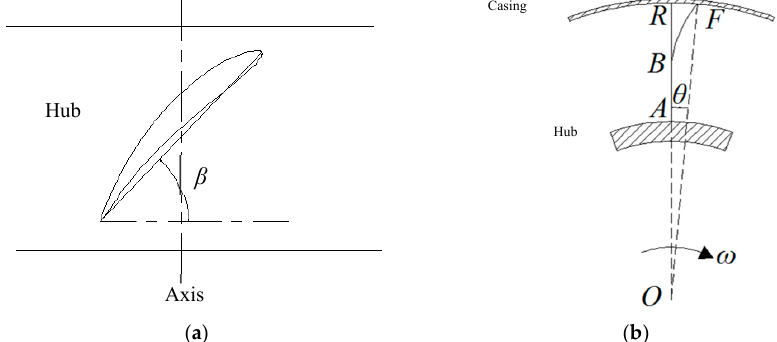
Figure 3. ( a ) Sketch of blade pitch angle; ( b ) sketch of stacking line and circumferentially forward-skewed angle.